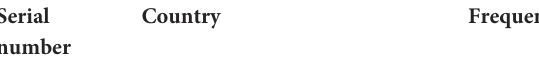
TABLE 1 Fifteen countries, led by Germany, participated in international cooperation in environmental